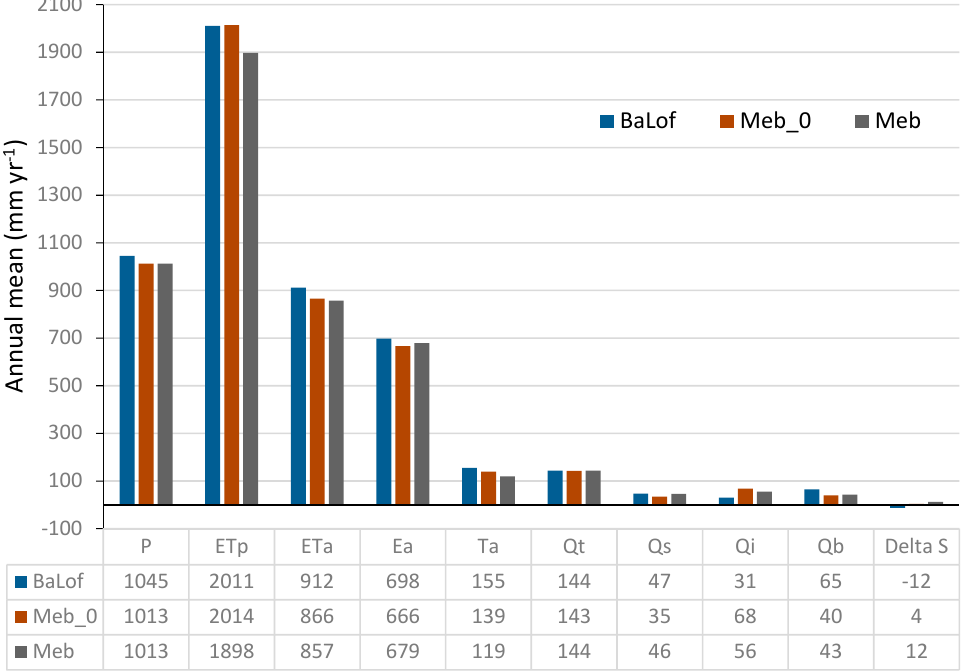
Figure 13. Annual mean water balance for Bankandi ‐ Loffing (BaLof), Mebar before recalibration (Meb_0), and after recalibration (Meb) for the period 2014–2016. P: precipitation; ETp: potential